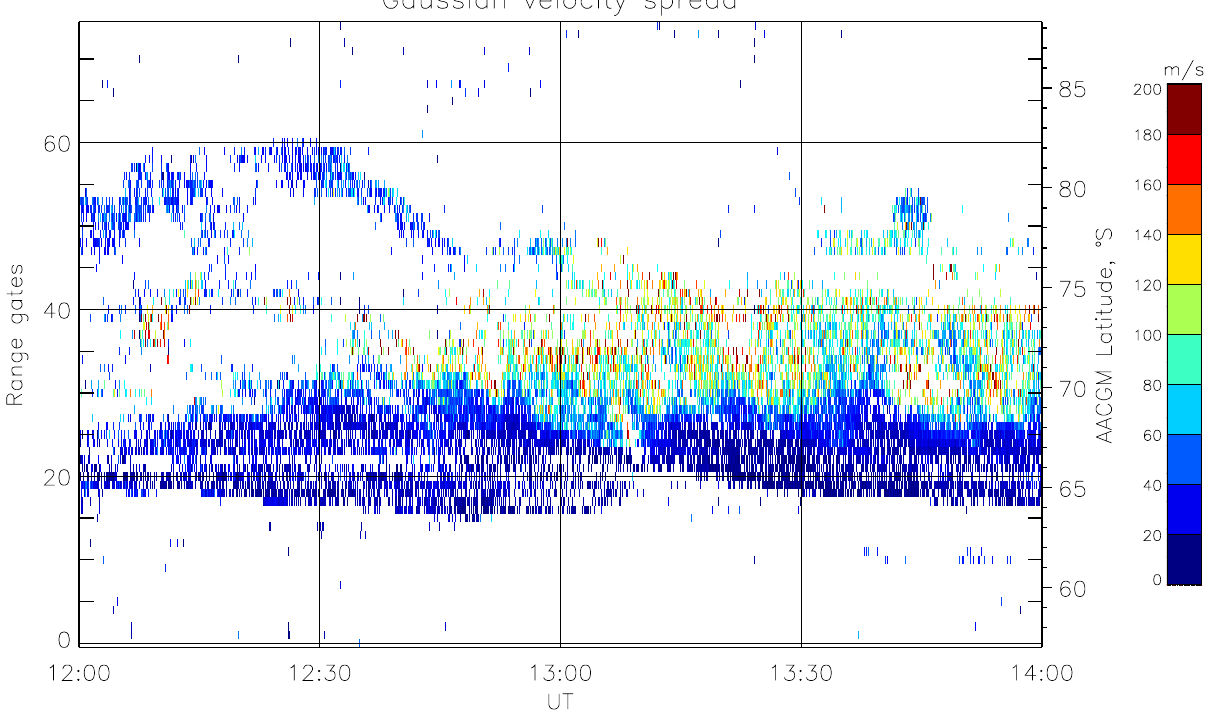
Fig. 17. Range-time map of the random velocity variation determined from Gaussian-shaped ACFs.